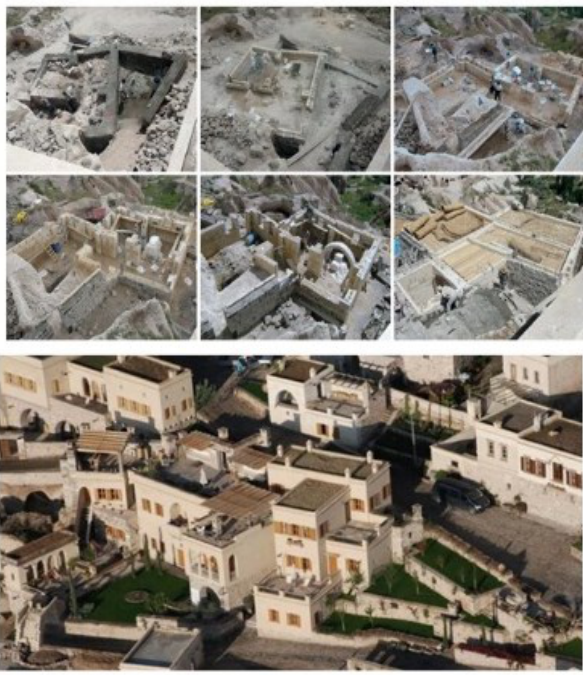
Figure 5. Restoration of Vernacular Housing Consulted by Cansever for Argos ( Arkiv, 2019 ).